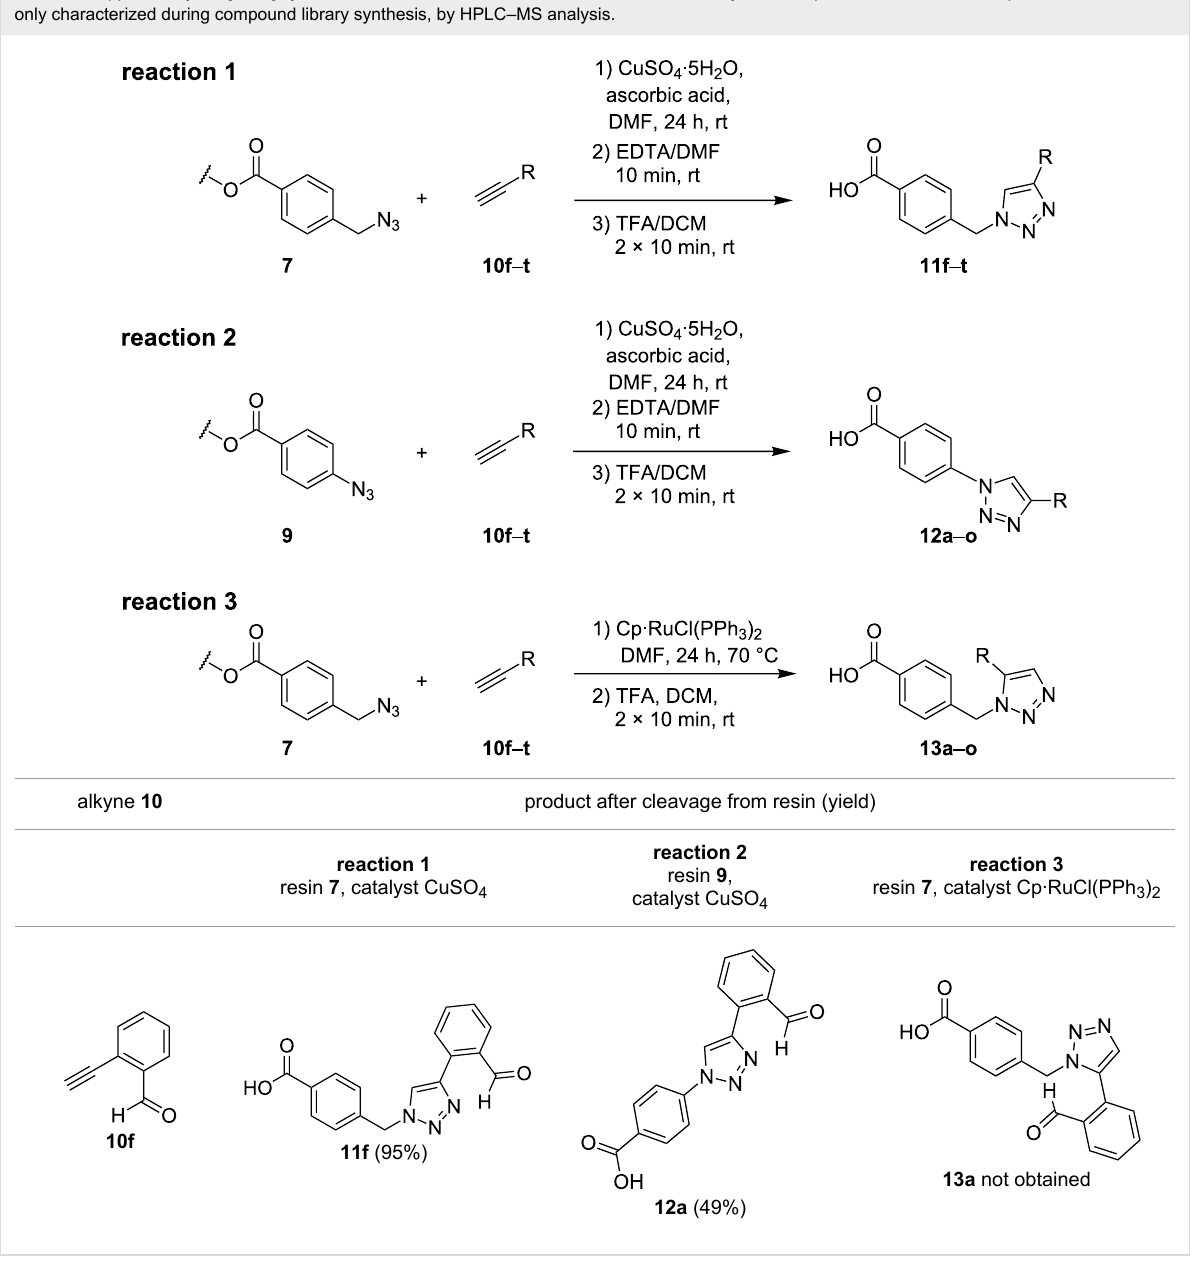
Table 2: Copper-catalyzed [2 + 3] cycloadditions of resin bound azide 7 with five terminal alkynes. Compounds 13 , with the exception of 13f , were only characterized during compound library synthesis, by HPLC–MS